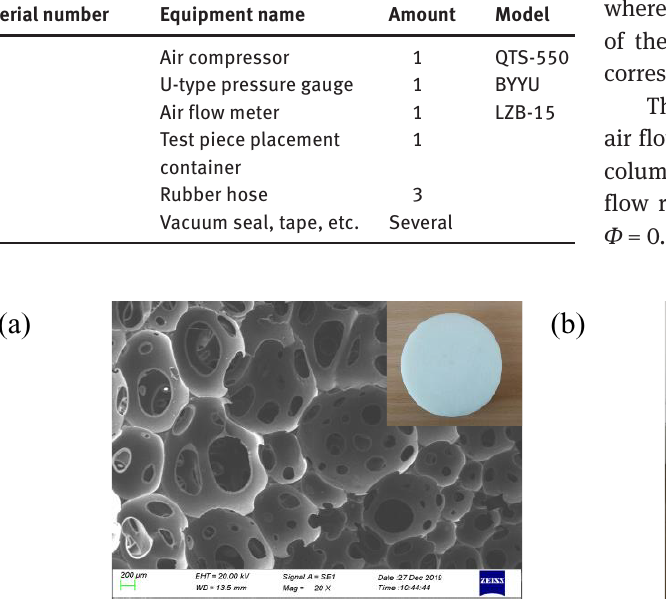
Table 1: Equipment and model of flow resistance measuring device. Serial